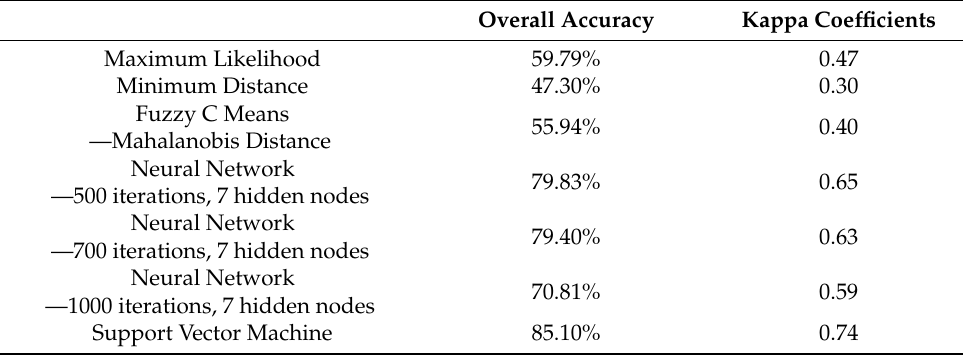
Table 6. Overall accuracy and kappa coefficients from the classifications.